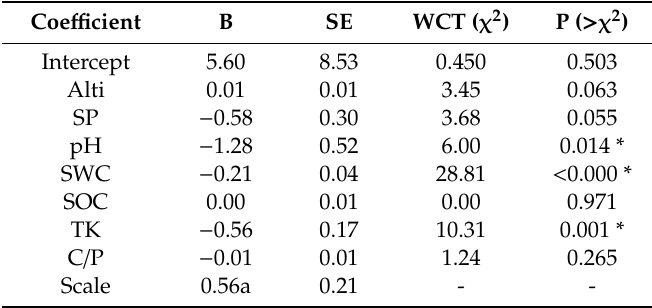
Table 3. Results of generalized linear models (GLMs) exploring factors in the e ff ects of the small gap soil topography gradient factors on plant species richness. Coe ffi cient B SE WCT ( χ 2 ) P ( > χ 2 ) Intercept 5.60 8.53 0.450 0.503 Alti 0.01 0.01 SP SWC − 0.21 28.81 SOC 0.00 0.01 0.971 TK 0.001 * − 0.01